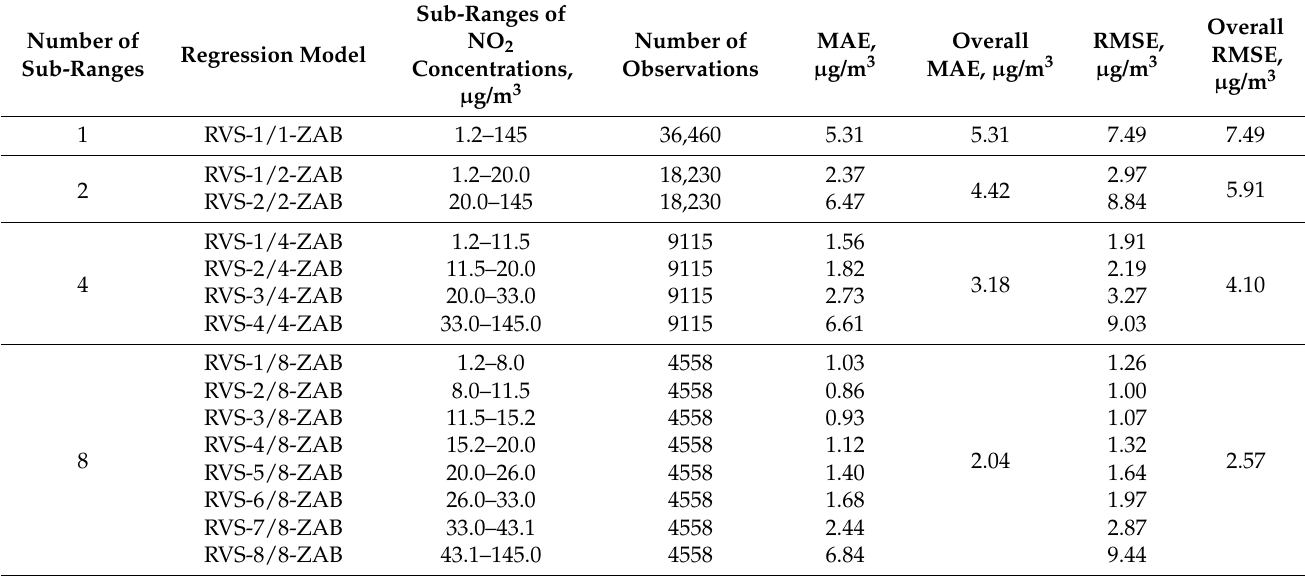
Table 13. Values of approximation errors of NO 2 concentrations in RVS models, Zabrze 2011–2016.